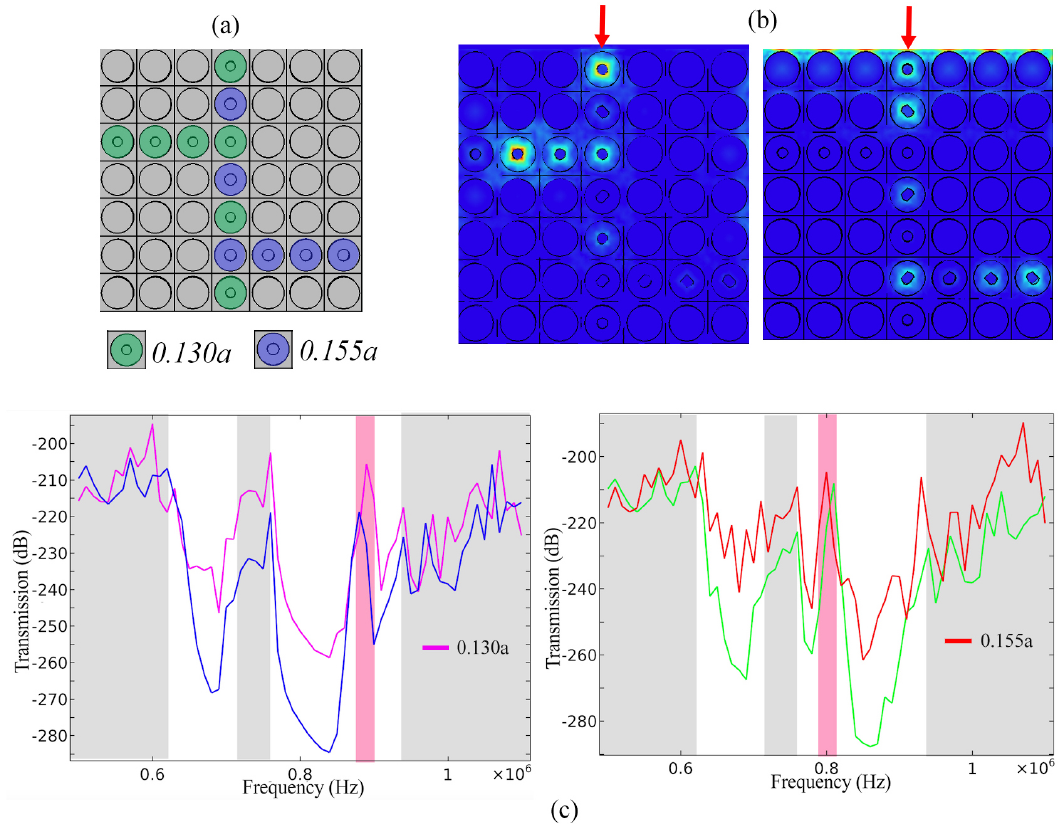
Figure 7. ( a ) Model for dual filtering frequencies with single channel, ( b ) displacement field for (left) 0.130 a at frequency 886 kHz and (right) 0.155 a at frequency 800 kHz. The red arrow indicates the incoming wave ( c ) comparison between transmission spectra for multiple channel system in Figure 6a with mono-channel system in ( a ) for (left) r i = 0.130 a and (right) r i = 0.155 a . The pink region marks the transmission region for both waveguides r i = 0.130 a and 0.155 a